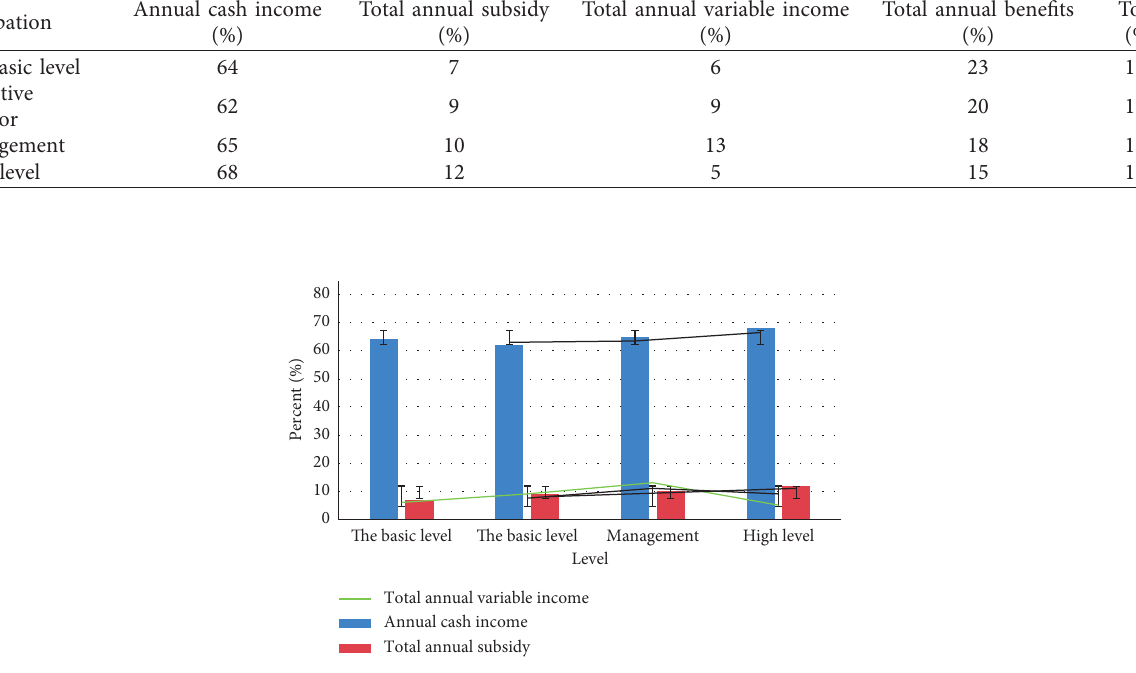
Figure 15: Salary structure of human capital in high-tech